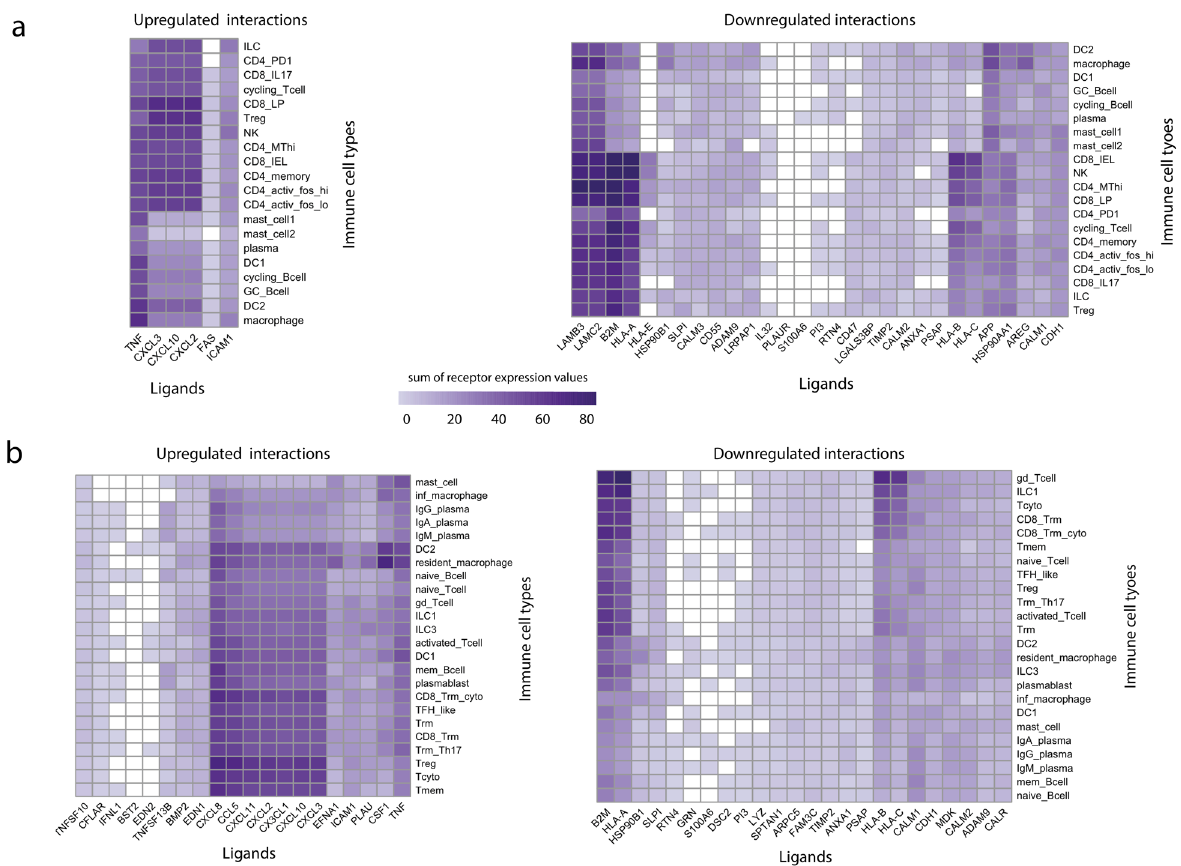
Fig. 7 Ligands of infected immature enterocytes involved in the strongest up and downregulated interactions upon SARS-CoV-2 infection in the colon and ileum. a , b Heatmap showing the upregulated and downregulated interactions in the colon ( a ) and ileum ( b ) between intestinal epithelial ligands and resident immune cells upon infection of immature enterocytes with SARS-CoV-2. The strength of the interaction is expressed by accounting for the number of interactions between epithelial ligands and immune receptors and the level of receptor expression of immune cells. The strength of the interaction, named “ sum of expression values ” , is visualised using a colour gradient from white (weakeast interactions) to purple (strongest interactions). Abbreviations: Ileum : inf_macrophage infected macrophage, mast mast cell, CD8_Trm_cyto Resident memory cytotoxic T cell, DC2 dendritic cell 2, Trm Tissue-resident memory T cell, gd_Tcell Gamma delta ( γδ ) T cells, ILC Innate lymphoid cell, mem_Bcell memory B cell, naive_Bcell naive B cell, TFH_like T follicular helper cells, Trm_Th17 Tissue-resident